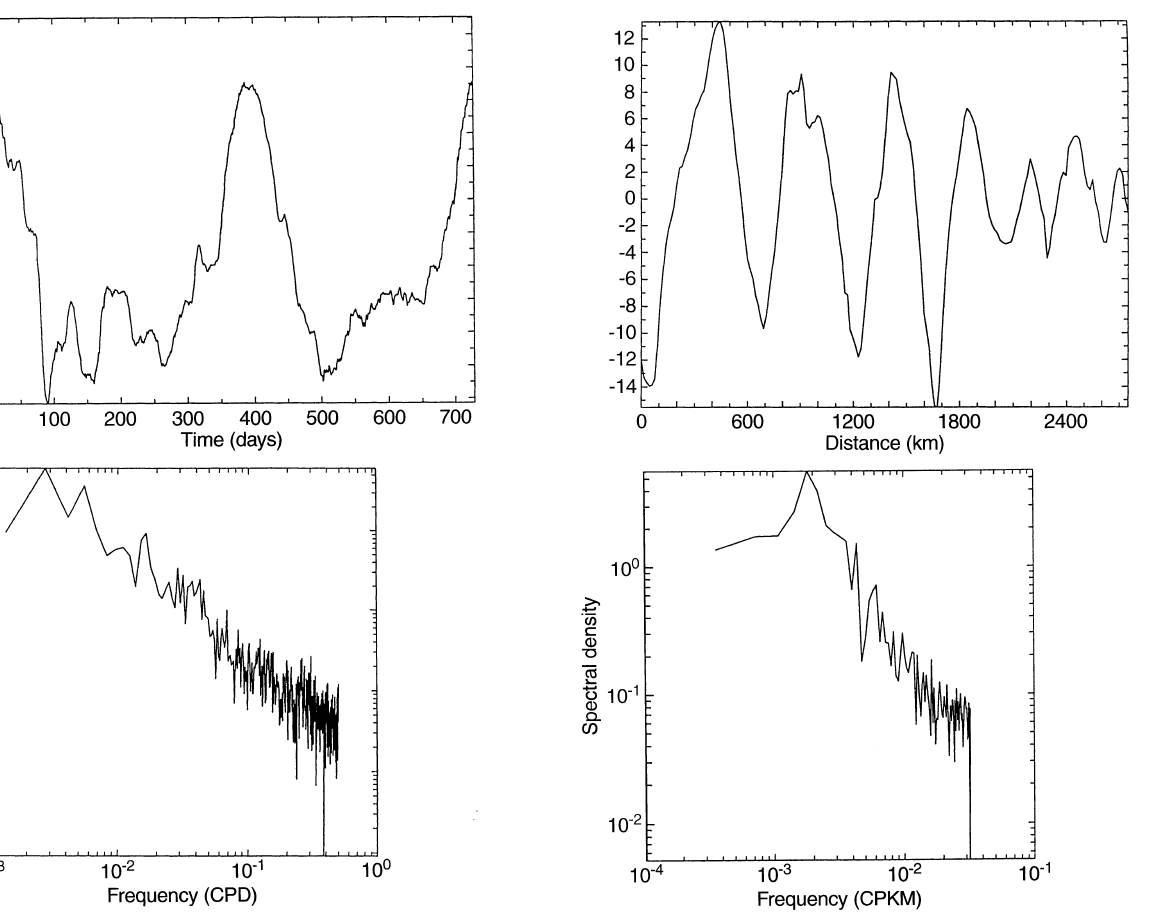
Fig. 16. Top : zonal section of the sea-level (in cm) at 34 (cid:176) N latitude, between 40 (cid:176) W and 10 (cid:176) W, on January 15, 1993; bottom : spectral density of this